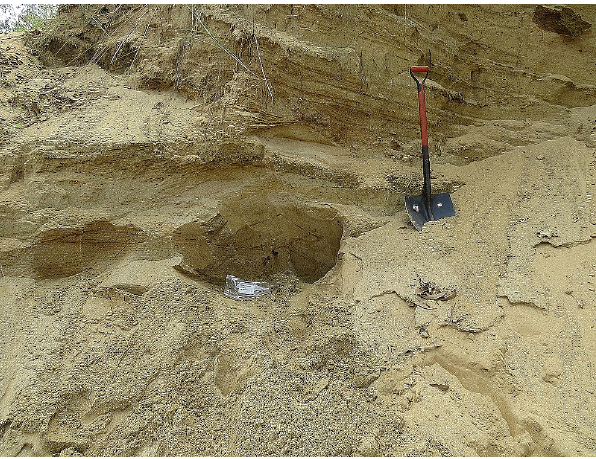
Figure A12. NGL – cross-bedded medium-coarse sand unit ∼ 10m above modern channel. Base of unit (S1) OSL dated at 14000 ± 3000 years by Sinha et al.